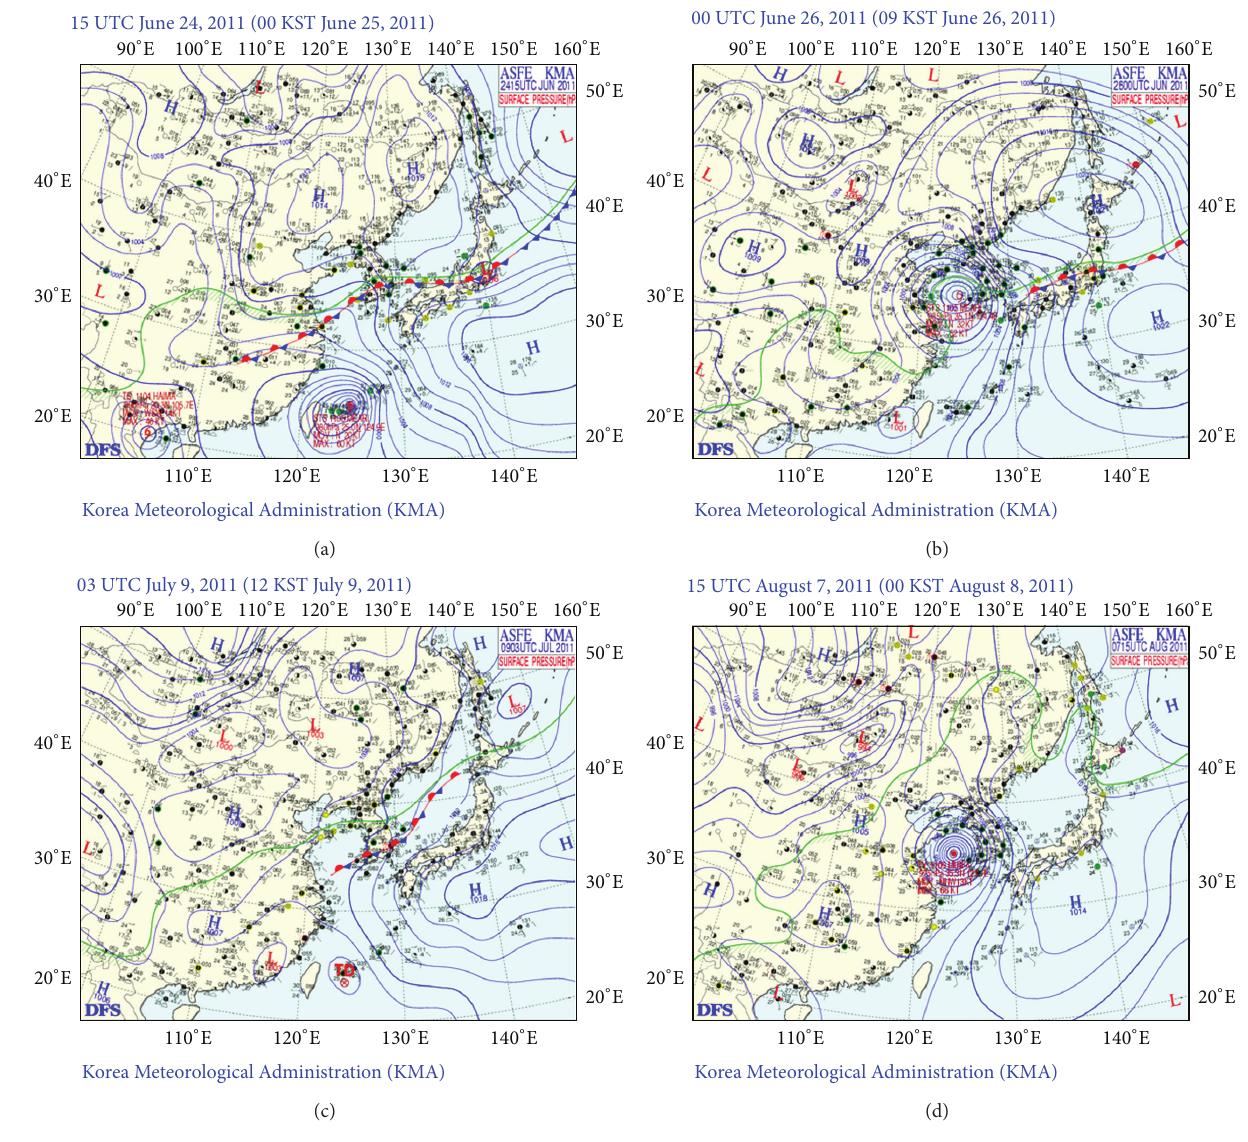
Figure 3: The surface weather chart (a) 0000 LST June 25, (b) 0900 LST June 26, (c), 1200 LST July 9, and (d) 0000 LST August 8 in 2011.